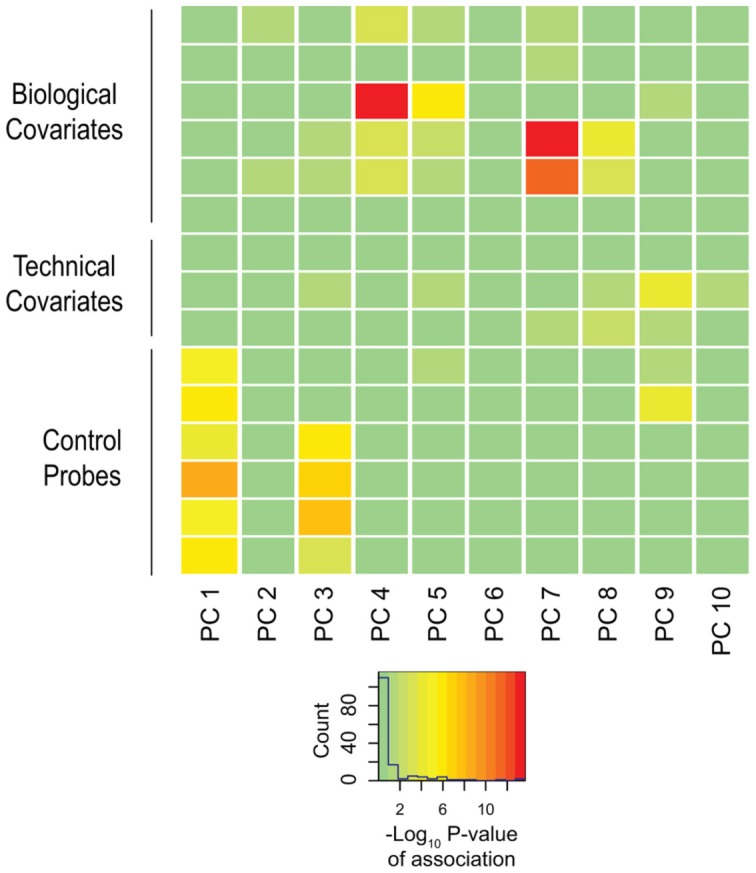
Biological and technical confounders contribute to methylation value variation.The heat map displays the –log10 p-values of the linear regressions of the top ten principal components onto each known covariate. The color key shows corresponding numeric values, with red indicating increased significance. The majority of variation is accounted for by experimental influences, with age and ancestry also contributing significantly to variation.